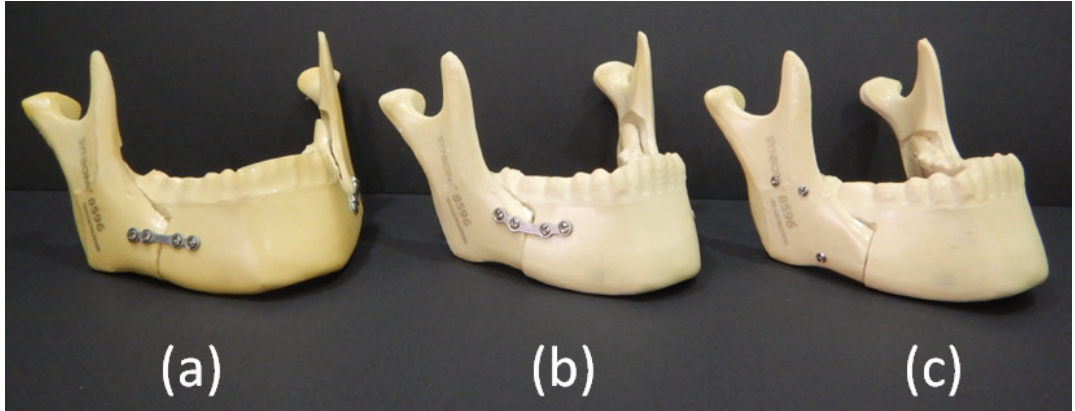
Figure 1. Fixation methods for bilateral sagittal split ramus osteotomies (BSSRO) used in this study: ( a ) Group 1: straight plate with four monocortical screw fixation. ( b ) Group 2: curved plate with four monocortical screw fixation. ( c ) Group 3: three–inverted L-type bicortical screw fixation group.